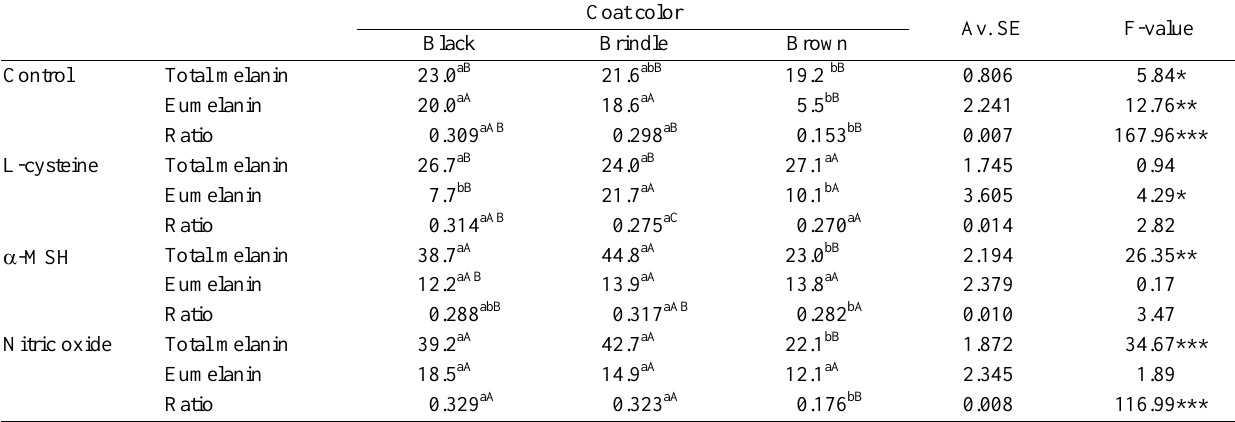
Table 1. Total and eumelanin contents (  g/4  10 5 cells) and their ratio in melanocytes from Black, Brindle and Brown Hanwoo muzzles treated with L-cysteine,  -MSH and nitric oxide Coat color Av. SE F-value Black Brindle Brown